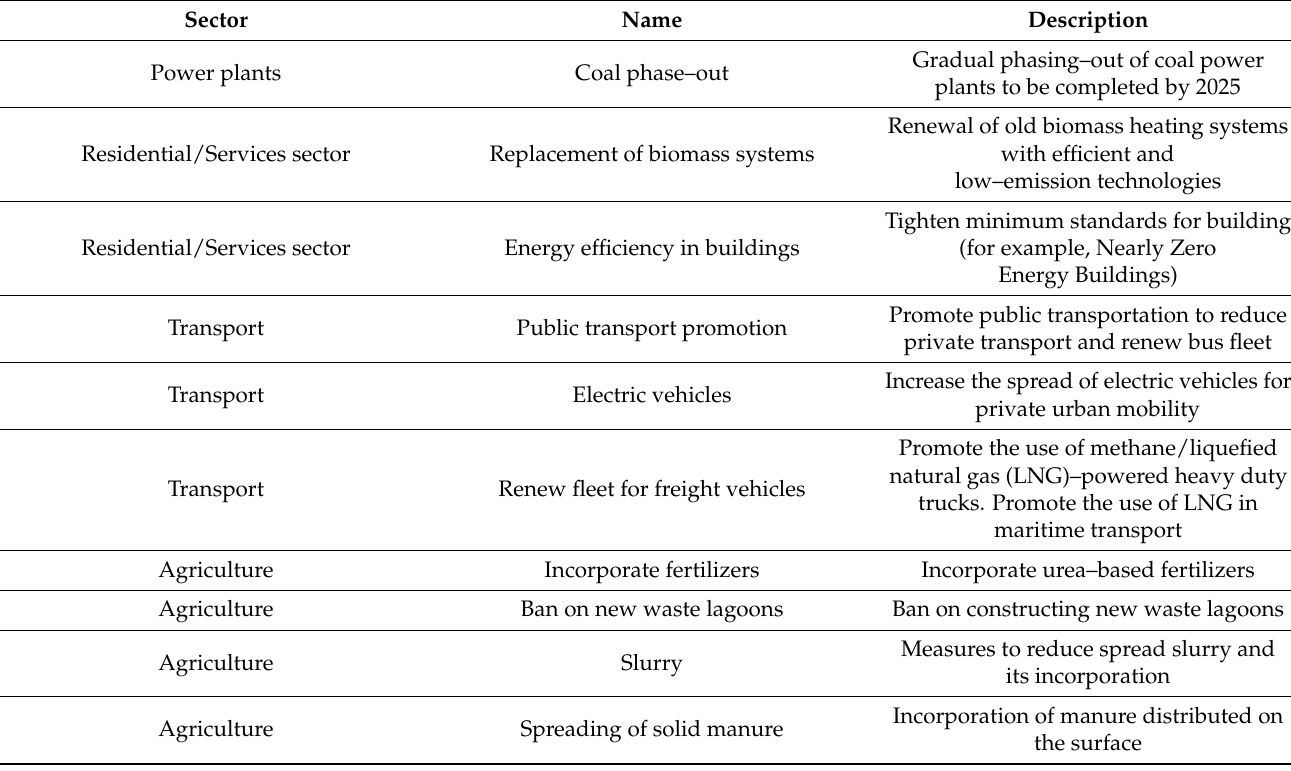
Table 1. Measures adopted in the 2030 “With Additional Measures” (WAM)